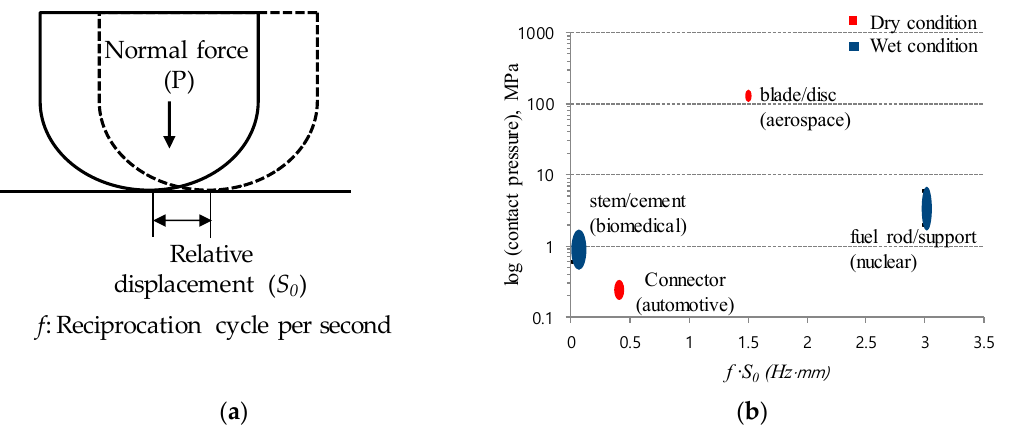
Figure 2. Experimental fretting conditions found in various industries: ( a ) Factors determining fretting; ( b ) Conditions found in various components. f and S 0 denote frequency and an imposed relative displacement, respectively.